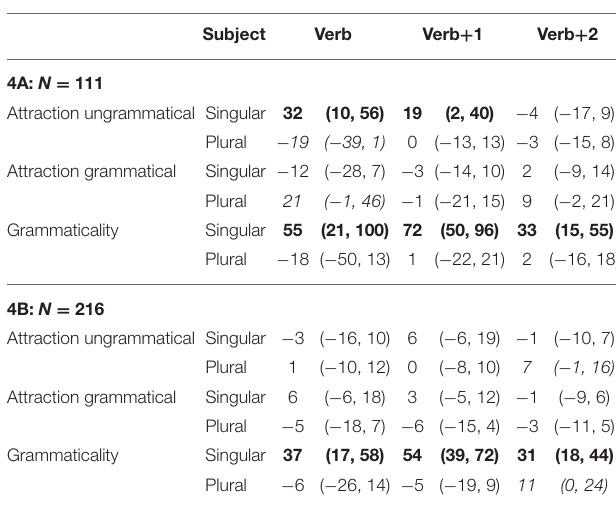
Table 7 | Results of experiment